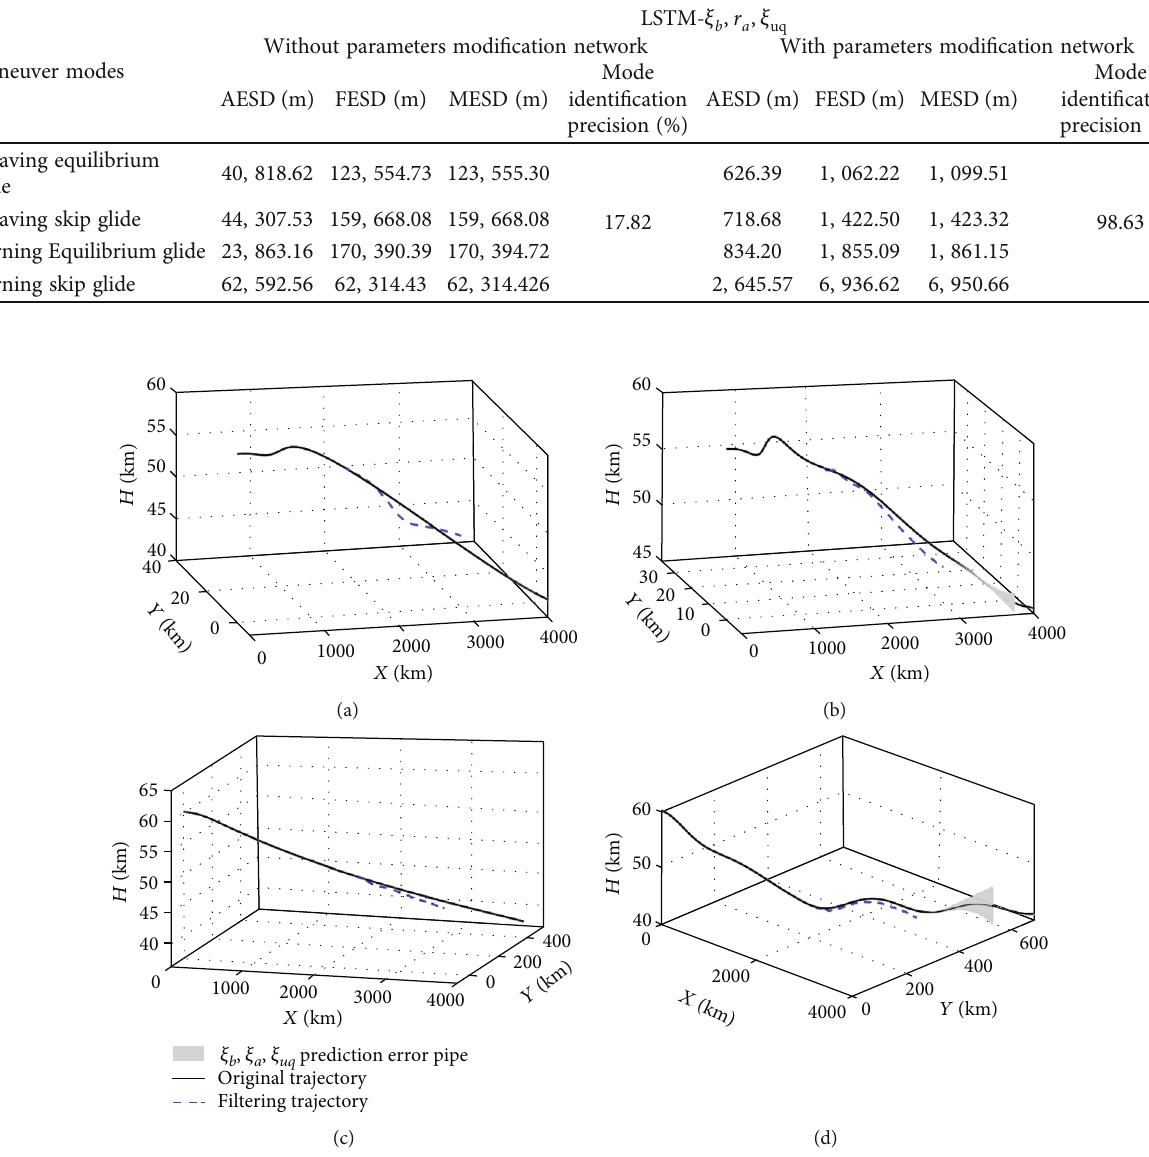
Table 3: Prediction result in 150s with and without parameter modi fi cation network.